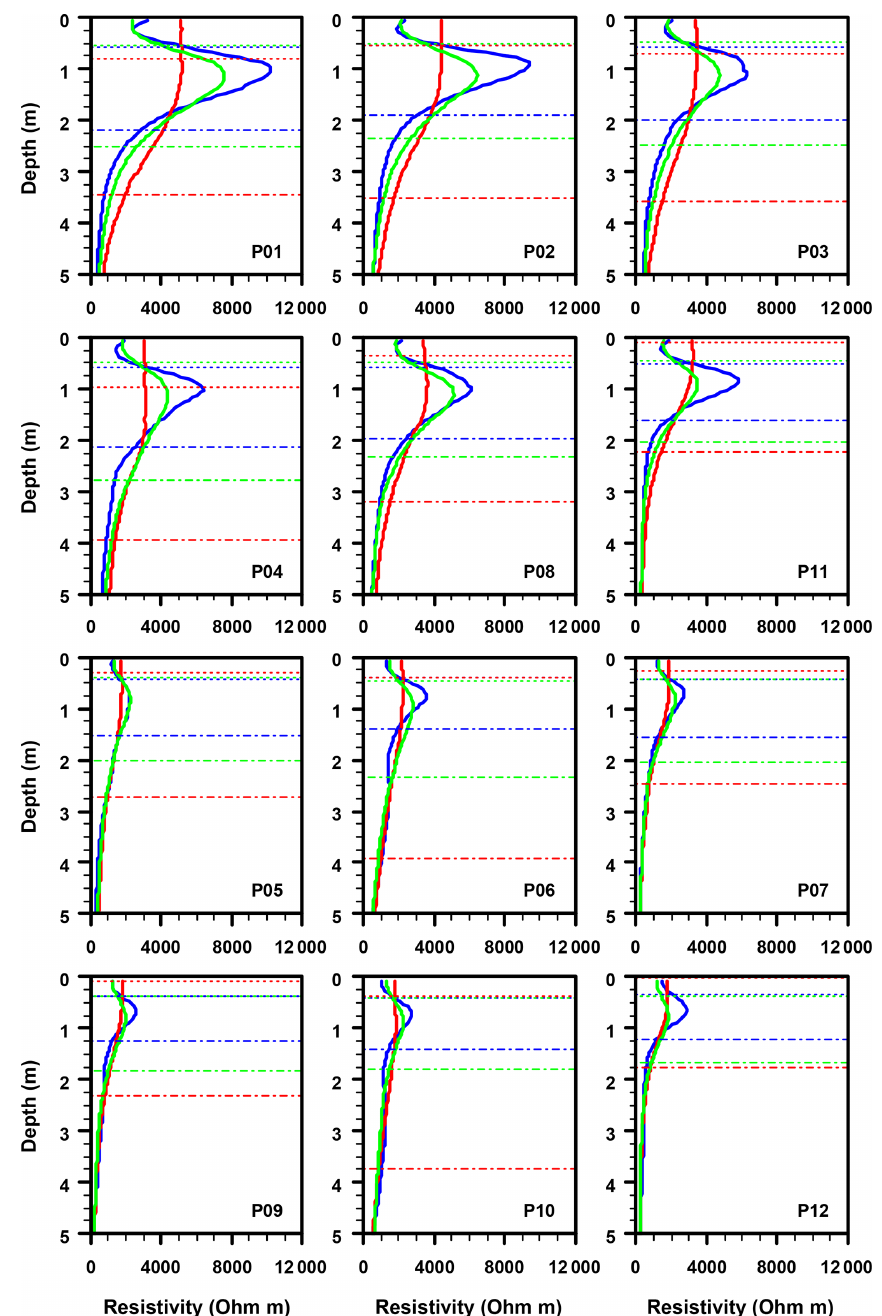
Figure 9. Median resistivity as a function of depth for the 12 plot-scale ERT profiles measured in the Weierbach catchment using an ES of 0.5m (blue thick curves) or 2m without (red thick curves) or with the four interpolated levels of surficial apparent resistivity (green thick curves). Median interface depths derived from the second derivative of ERT images are indicated by thin dashed lines for solum thickness and thin dot-dashed lines for depth to hard bedrock (coloured in the same way as the median resistivity